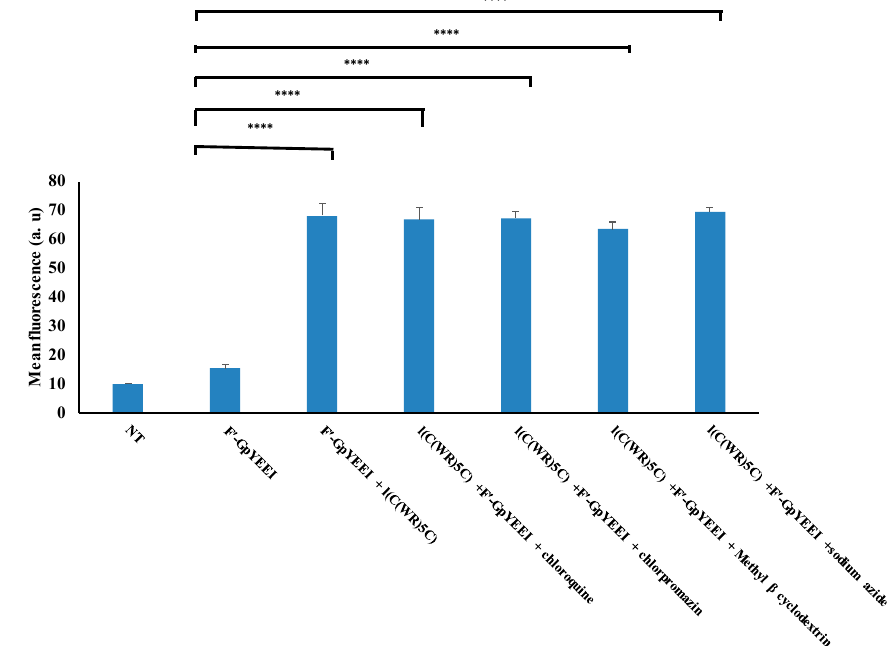
Figure 10. FACS analysis of the uptake of F ′ -GpYEEI (5 µM) using synthesized peptide l(C(WR) 5 C) (25 µM) in the presence of different endocytic inhibitors in MDA-MB-231 cells after 3 h incubation ( n = 3, if p < 0.05 then *, if p < 0.01 then **, if p < 0.001 then ***, if p < 0.0001 then ****). Error bars are SD.